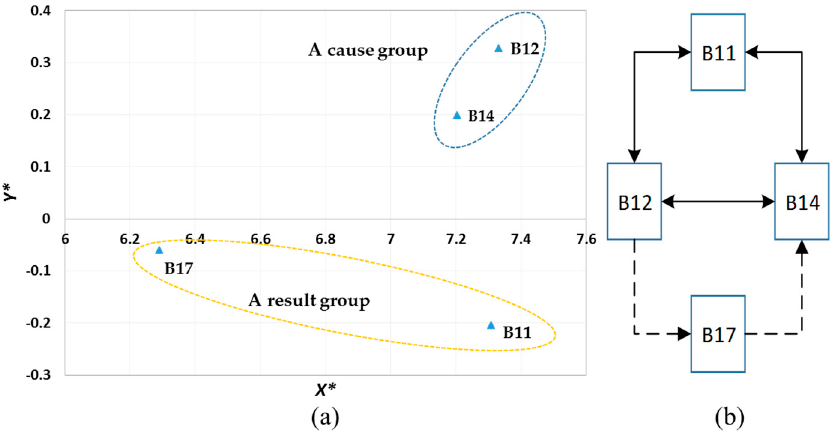
Figure 6. Cause and effect diagrams for the policy and regulation. ( a ) The sub-criteria causal attributes affiliated with the group and ( b ) the significant relations between these sub-criteria.